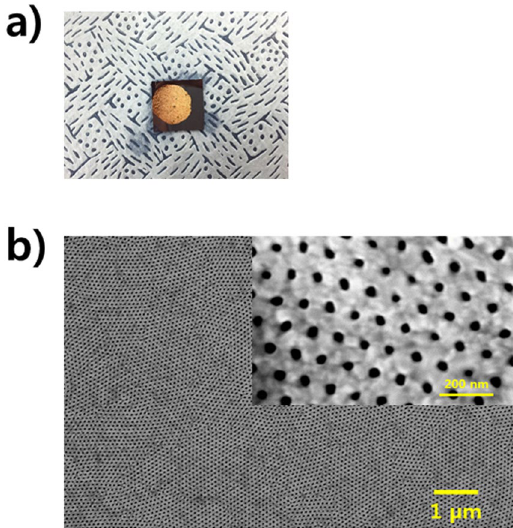
Figure 2. ( a ) Photograph and ( b ) SEM image of the Au nanomesh on a MoS 2 flake/SiO 2 /Si with a hole size of 30–50 nm and a neck width of 40–50 nm. Inset: Magnified SEM image of the Au nanomesh.